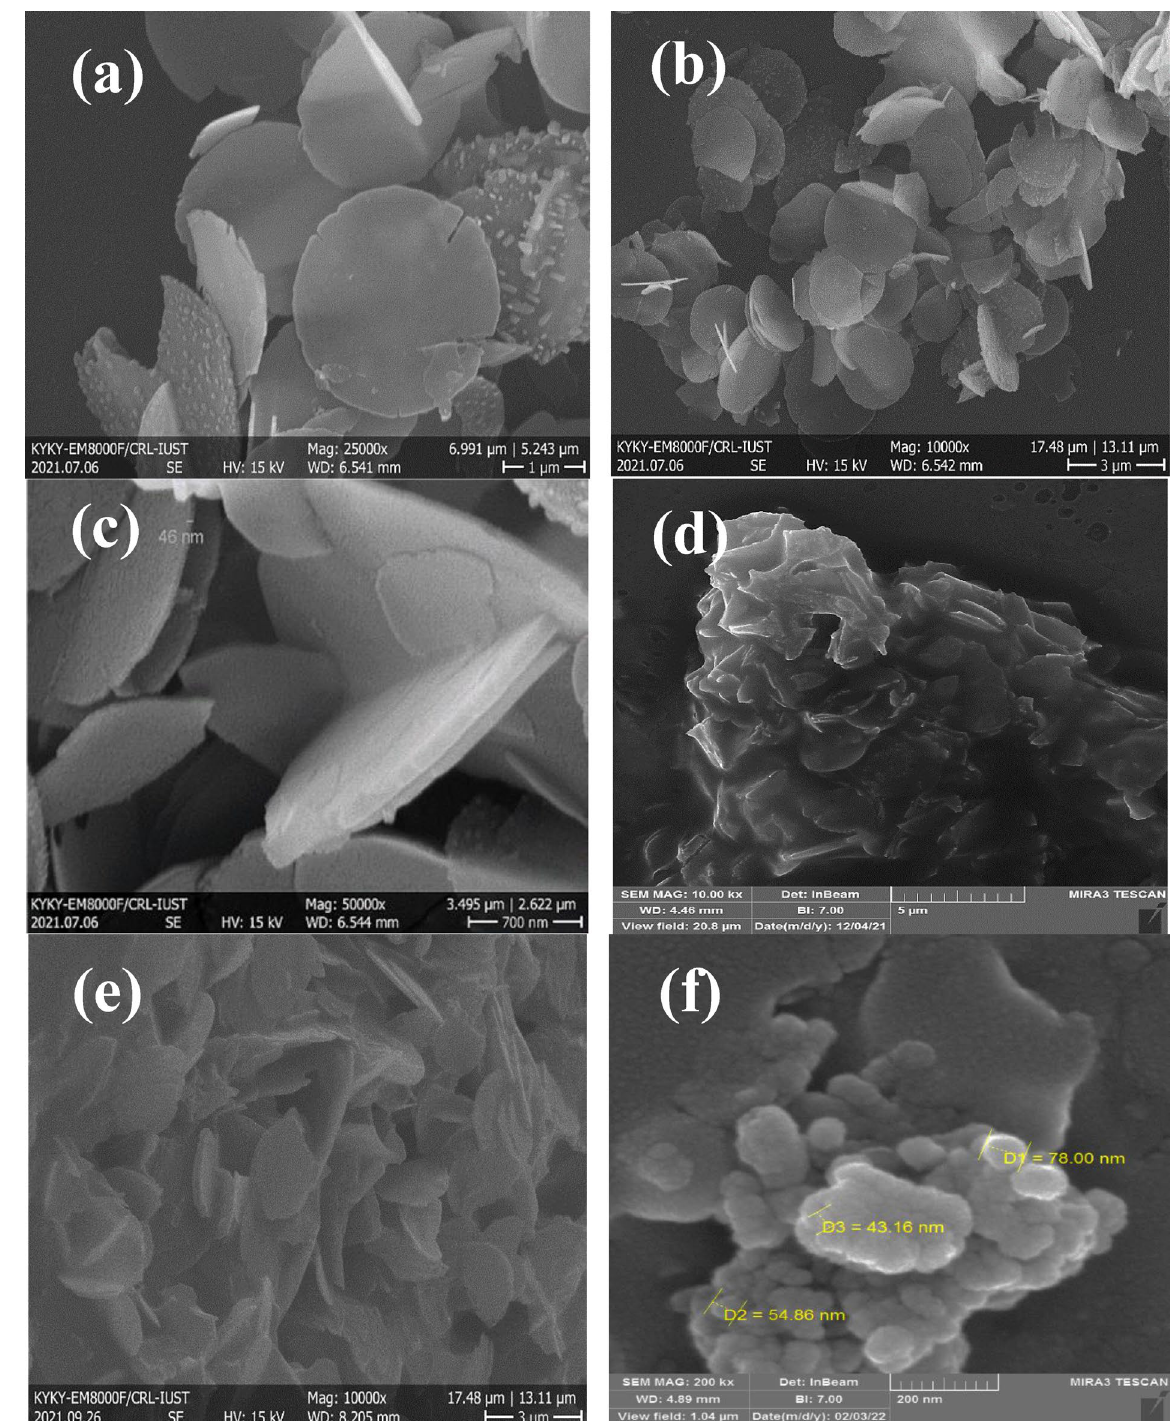
Figure 4. FESEM images of the Mg–Al LDH ( a , b , c ), and LDH–APS–PEI–DTPA nanocomposite ( 1 , d , e , f